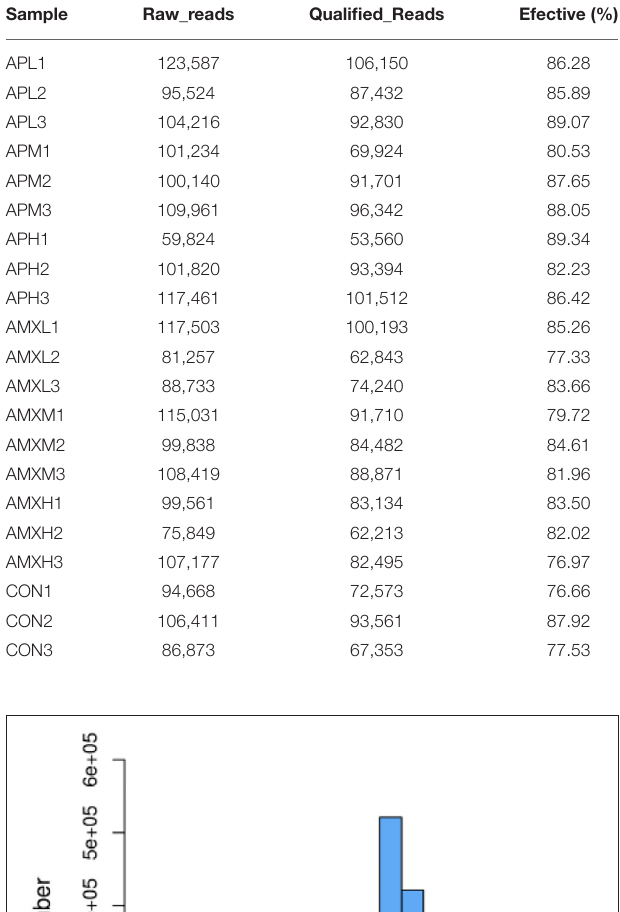
TABLE 1 | The sequence information of each sample.